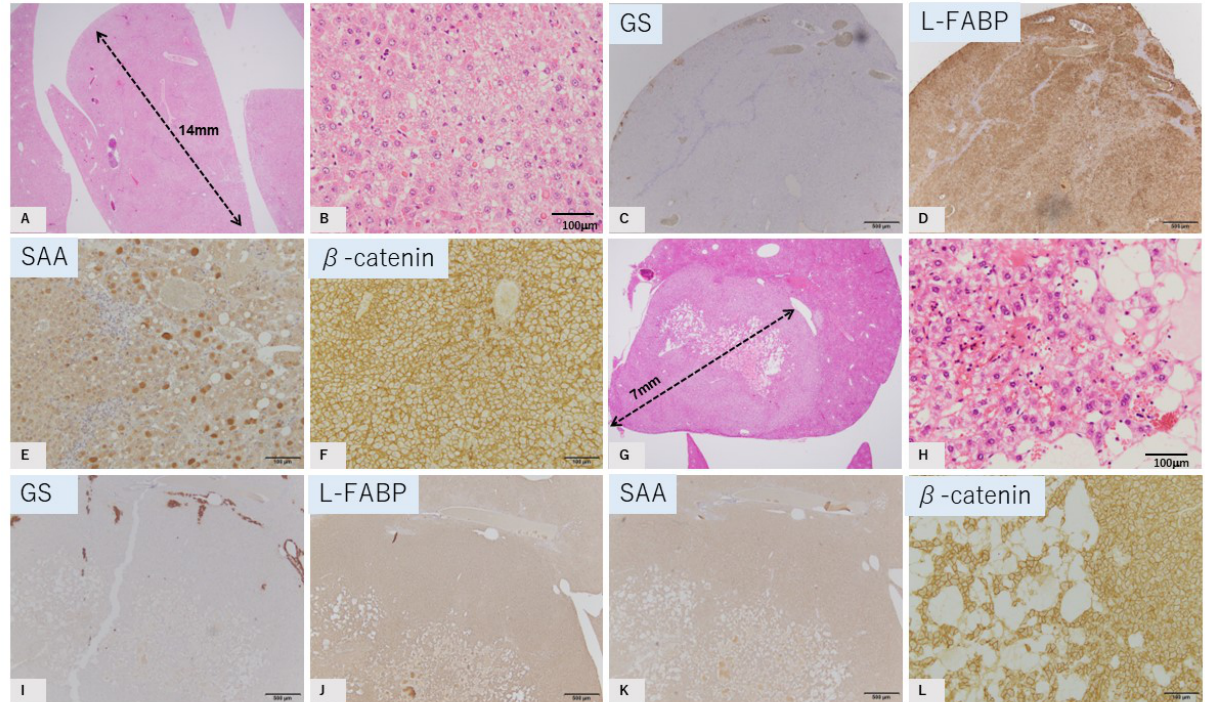
Figure 3. GS-negative tumor mimics of inflammatory HCA. Tumor 2, A – F ; and G – L : tumor 4. HE staining ( A , B , G , H ). Immunostaining of GS ( C , I ), L-FABP ( D , J ), SAA ( E , K ), and b-catenin ( F , L ). Tumor shows a trabecular pattern of hepatocytes with mild vacuolation. Occasional sinusoidal dilatation was observed with sparse aggregation of inflammatory cells. No capsule is observed. GS: negative, L-FABP: positive, SAA: strong positive staining is observed in parts of ( E ) and no strong staining was seen in ( K ), b-catenin: membranous staining. Tumor diameter is 14 mm in tumor 2 ( A ) and 7 mm in tumor 4 ( G ) (scale: C – F , I – L , 500 μm; B , H , 100 μm).